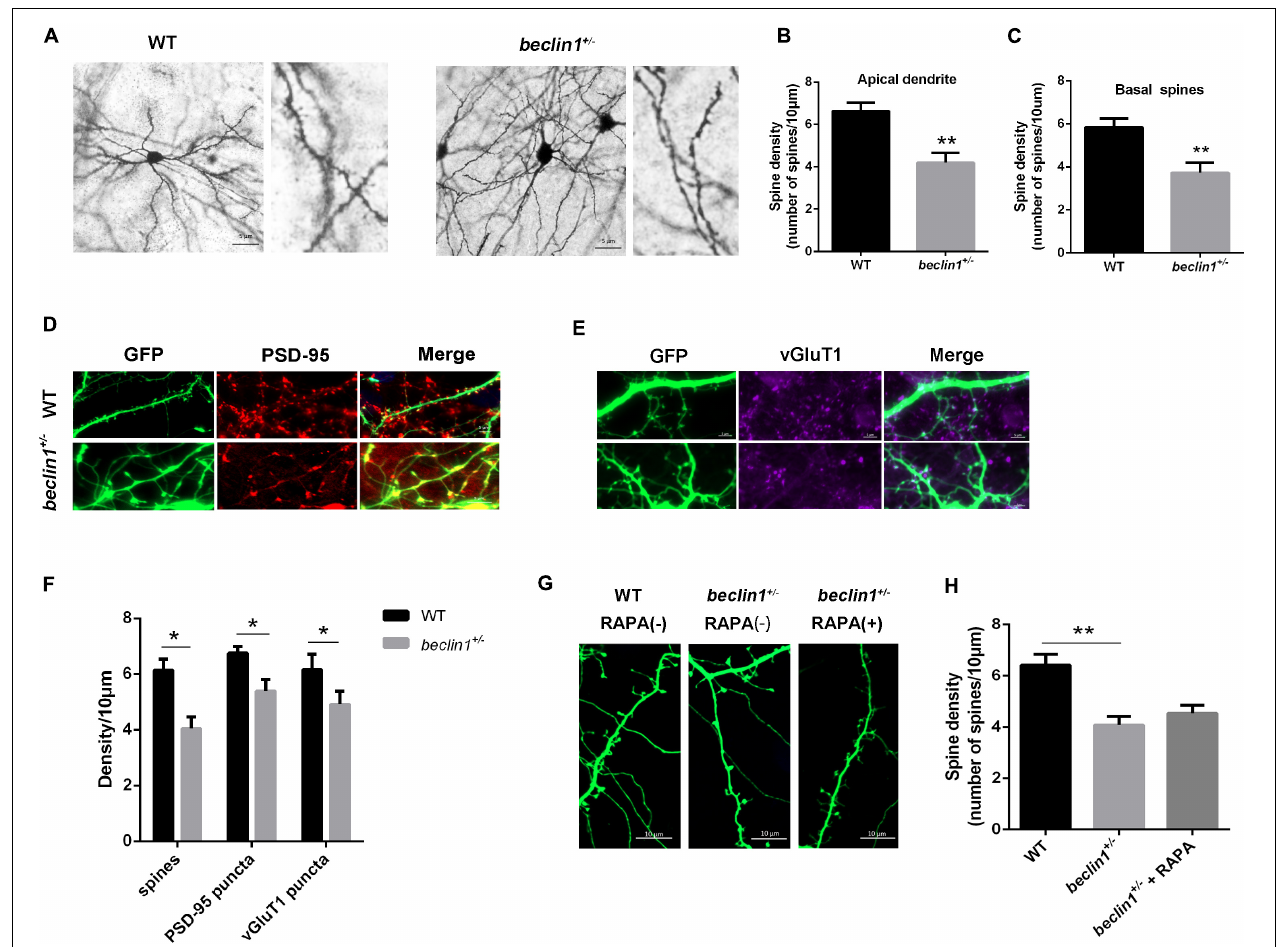
FIGURE 6 | Knockdown of beclin1 altered the dendritic spine density. (A) Representative image of the apical dendritic spine morphology of pyramidal neurons in brain slices from wild-type (WT) and beclin1 ± mice detected using Golgi staining. Scale bars: 5 µ m. (B,C) Quantification of the apical and basal dendritic spine density in the two groups ( n = 5 mice/genotype, 21 cells from WT mice and 16 cells from beclin1 ± ). (D,E) Representative image of dendrites and PSD-95/vGluT1 staining in cultured neurons from the two groups. (F) Quantification of the dendritic spine density and PSD-95/vGluT1 puncta density in the two groups ( n = 12 cells). (G,H) Representative image and quantification of the dendritic spine density in cultured neurons from WT and beclin1 ± mice under basal conditions and upon autophagy induction (RAPA) ( n = 3 mice/genotype, 15 neurons per group). Spines on apical dendrites in the stratum radiatum (SR) located within 20 µ m from the soma were counted. Data are presented as the means ± SEM. * p < 0.05 and ** p < 0.01. Student’s t -tests and one-way ANOVA were